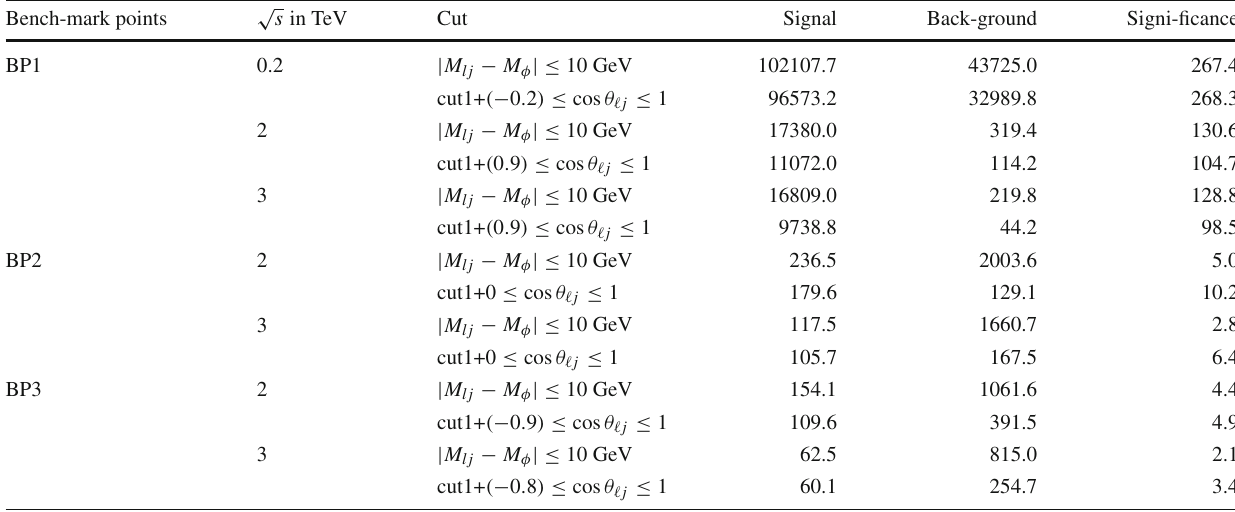
/ 3 ) c with luminosity 100 fb − 1 at e – γ collider 2 μ